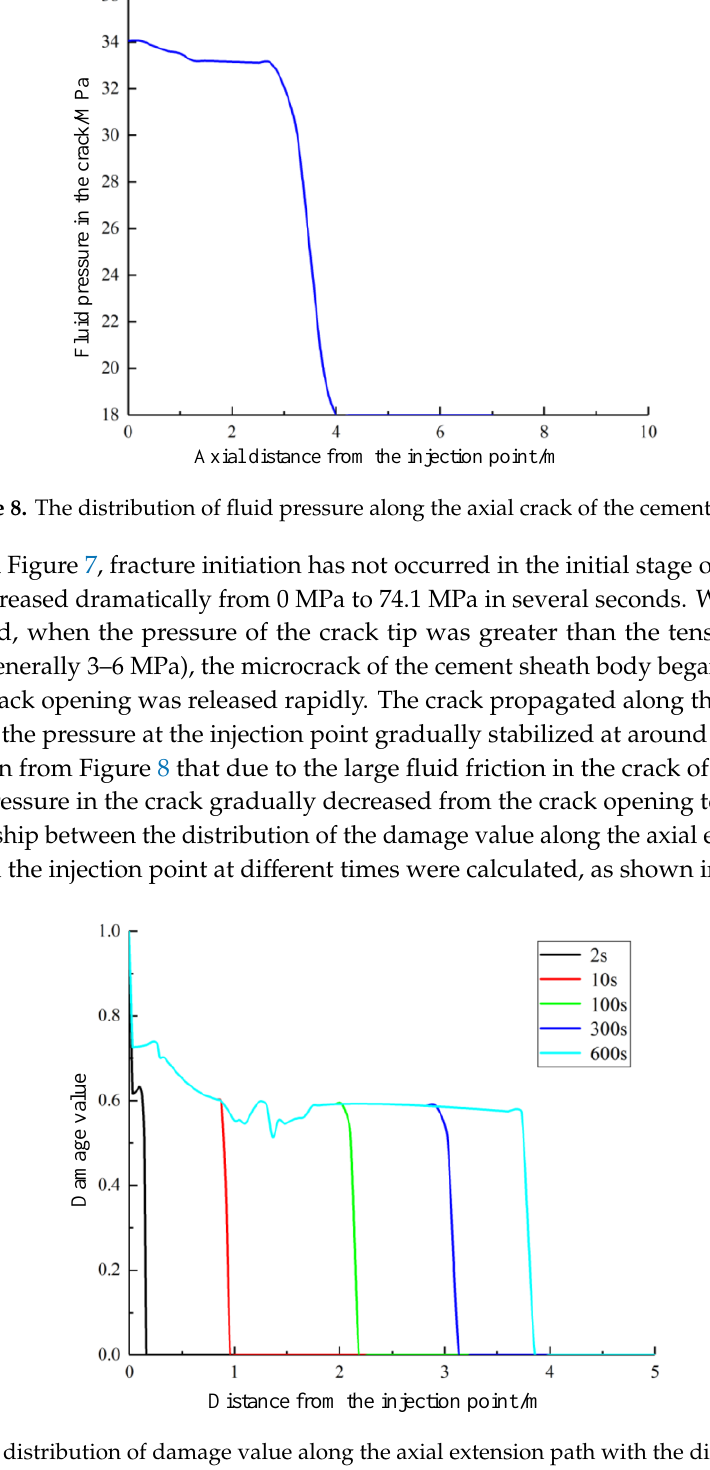
Figure 7. The relationship between the pressure at the injection point and the injection time.